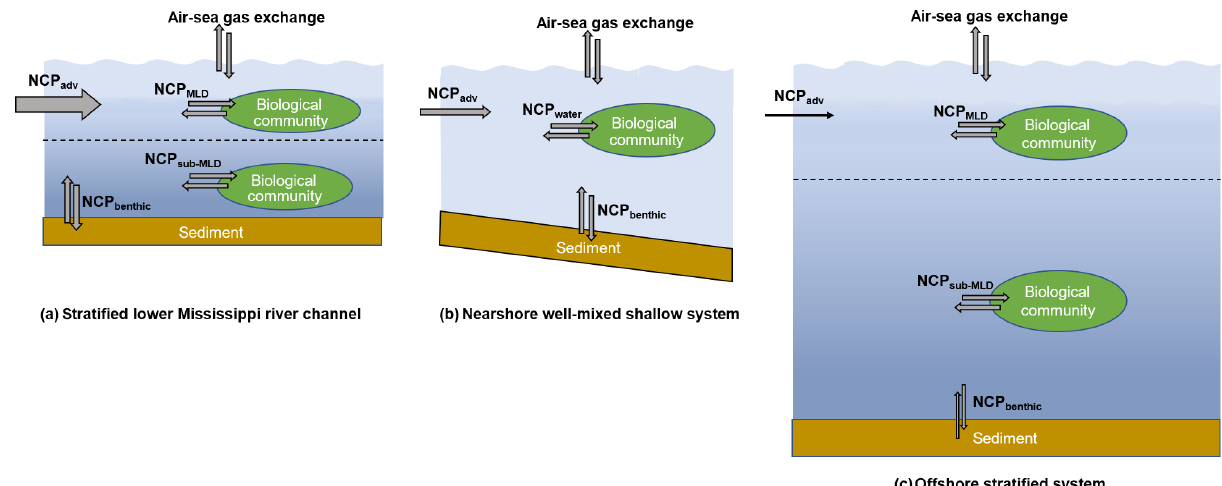
Figure 9. The differences in water column mixing conditions in the nGOM and their influences on NCP estimation. The dotted lines in (a) and (c) indicate the mixed layer depth. In the stratified lower Mississippi River channel (a) and the offshore stratified system (c) , NCP DO-incub equals the in situ community production in the mixed layer (NCP MLD ), while NCP O reflects the combined result of the NCP MLD and the 2 Ar influence of lateral advection of the river water (NCP adv ). In the nearshore well-mixed shallow system (b) , NCP DO-incub equals the water column community production (NCP water ), while NCP O reflects the combined result of NCP water , NCP benthic , and NCP adv . Note that 2 Ar the influence of NCP adv decreases offshore with the increasing water residence